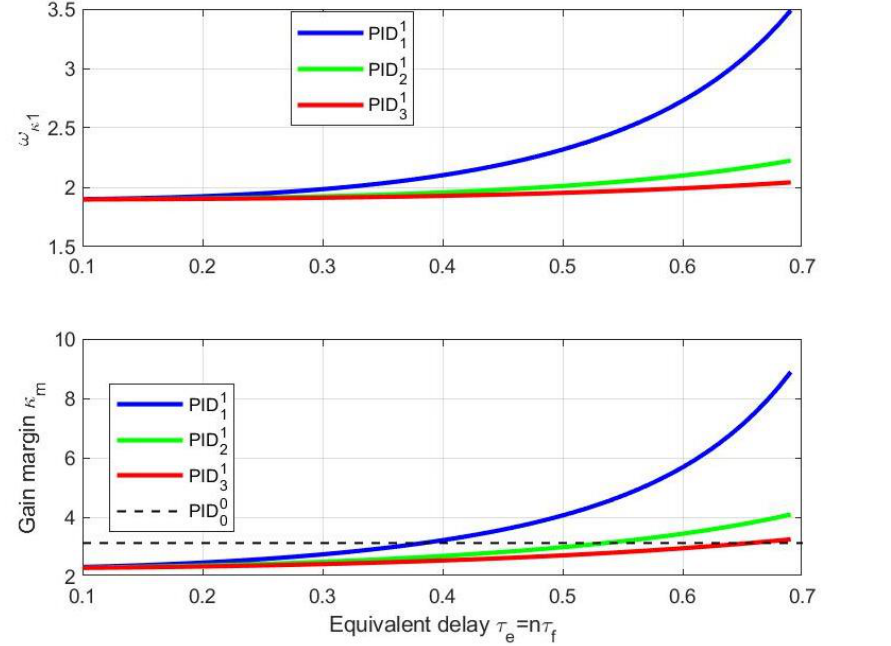
, PID 1 , and PID 1 controllers for T dp = 1 2 3 1